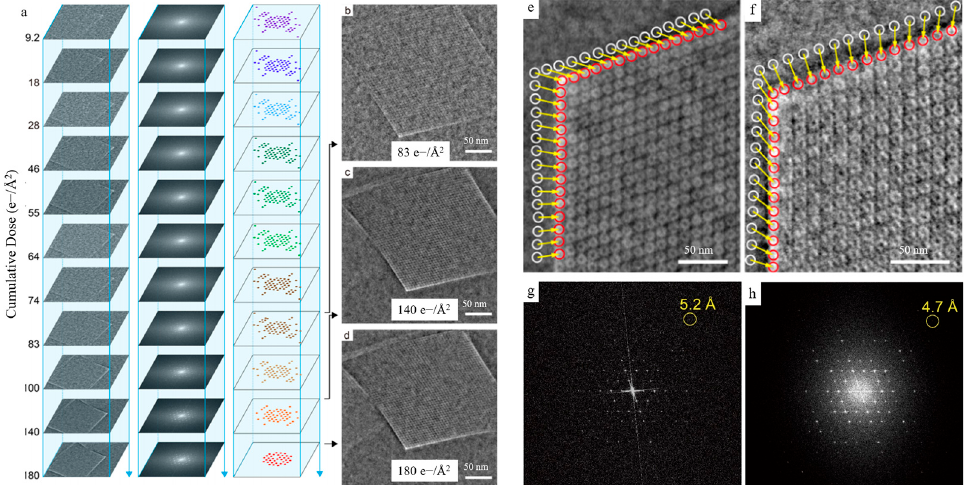
Figure 18. ( a ) a series of iDPC-STEM images with the increased cumulative electron beam doses; ( b – d ) iDPC-STEM under different dose; ( e , f ) iDPC-STEM images before and after irradiation; ( g , h ) the corresponding FFT. Reprinted/adapted with permission from Ref. [116]. Copyright 2020, American Chemical Society.